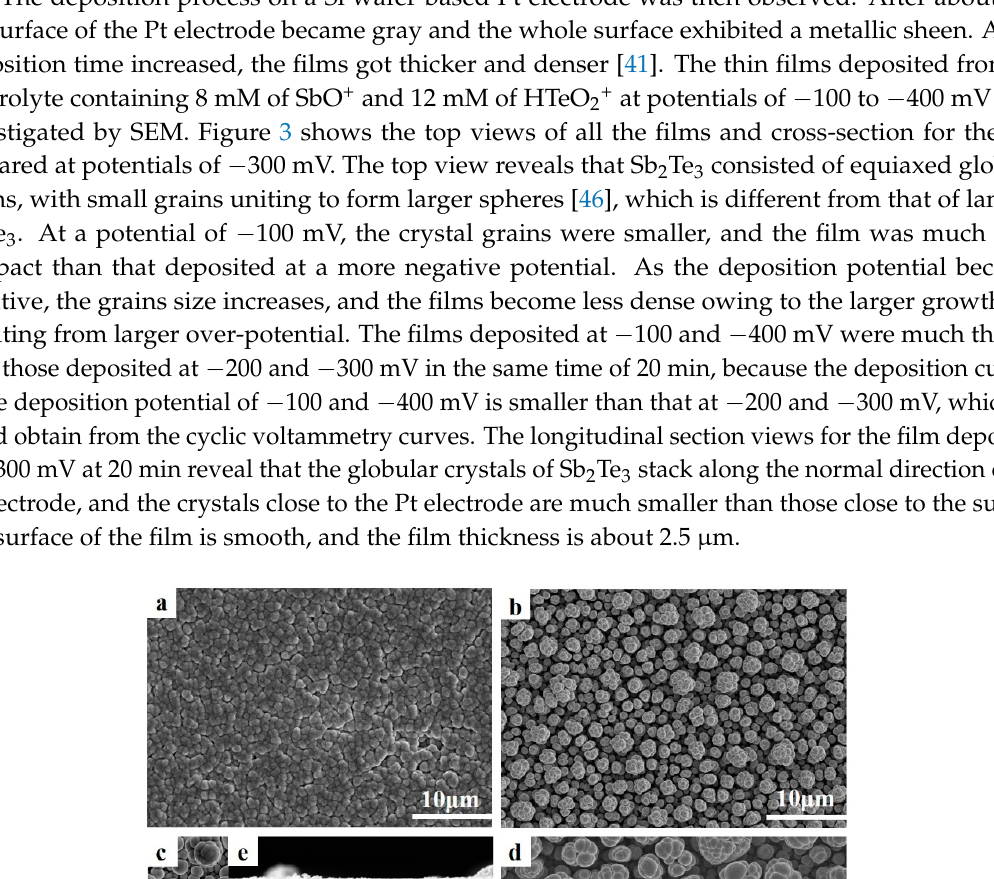
Figure 2. ( a ) EDS results for films deposited with electrolyte consisting of 8 mM of SbO + and 8–15 mM of HTeO 2+ ; ( b ) XRD pattern of the film deposited in 8 mM of SbO + and 12 mM of HTeO 2+ at a potential of − 0.3 V.